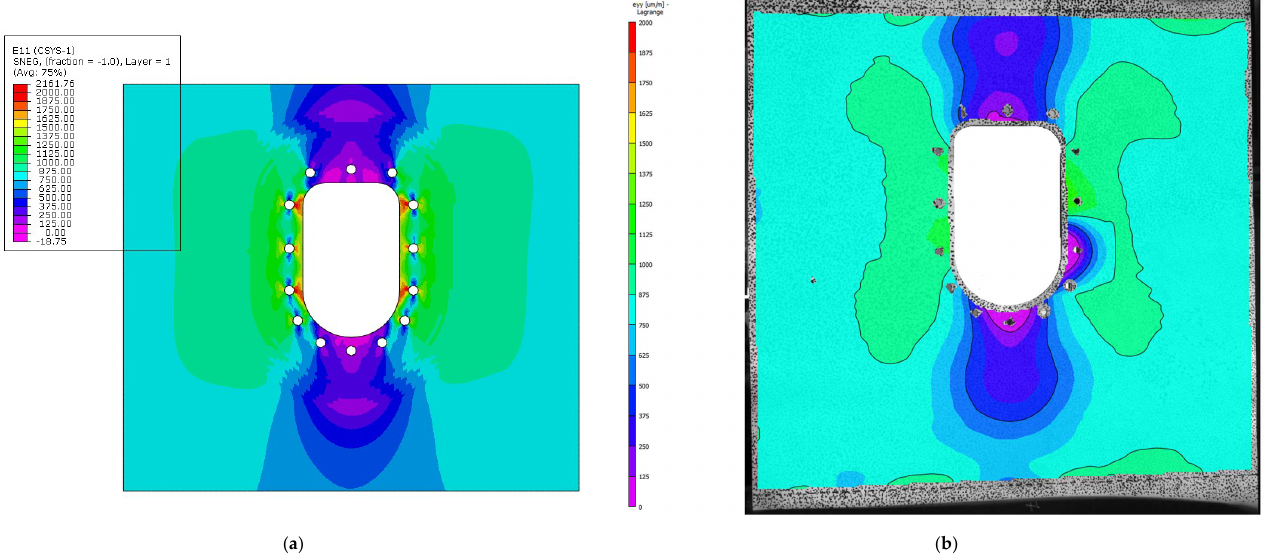
Figure 22. ( a ) Strain contour in the loading direction according FE analysis (9000 kg) and ( b ) strain contour in loading direction according to DIC (9000